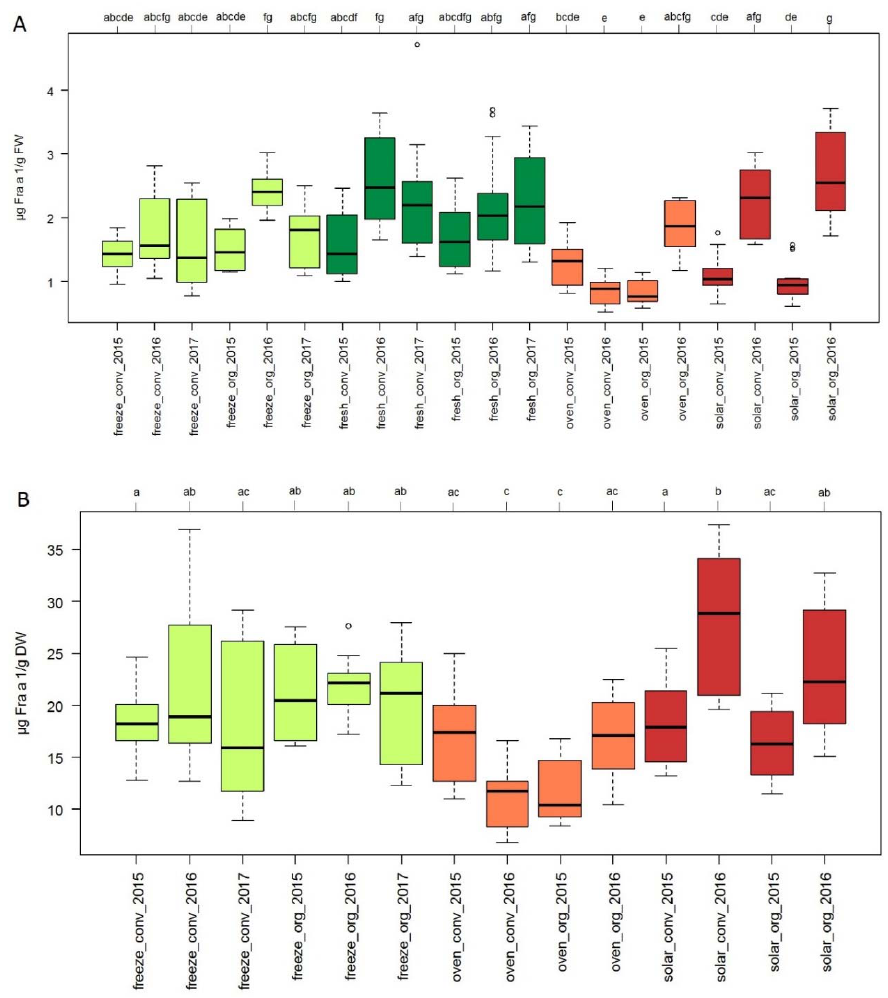
Figure 3. Fra a 1 content in fresh and dried fruits of strawberry cultivar Asia. ( A ) Allergen content in µg Fra a 1/g FW and ( B ) µg Fra a 1/g DW determined with indirect competitive ELISA. Plants